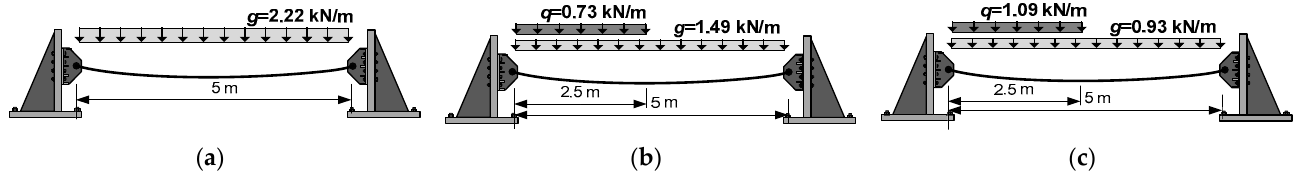
Figure 3. The bridge prototypes’ loading schemes: ( a ) symmetrical load; ( b ) asymmetrical load ( q / g = 0.49); ( c ) asymmetrical load ( q / g = 1.17).